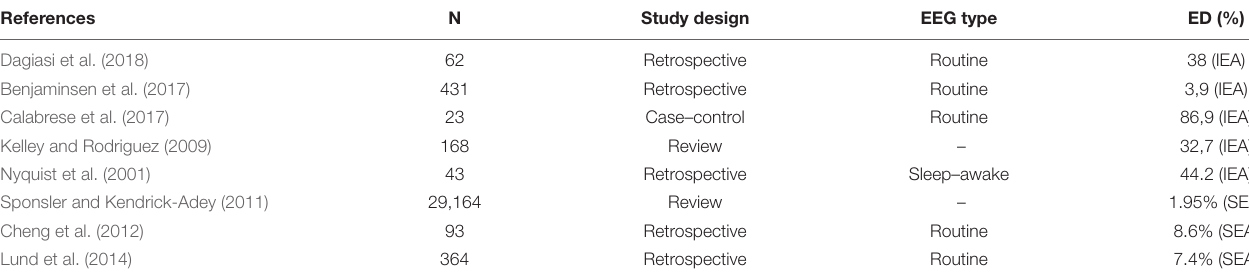
TABLE 2 | Prevalence of epileptiform discharges in multiple